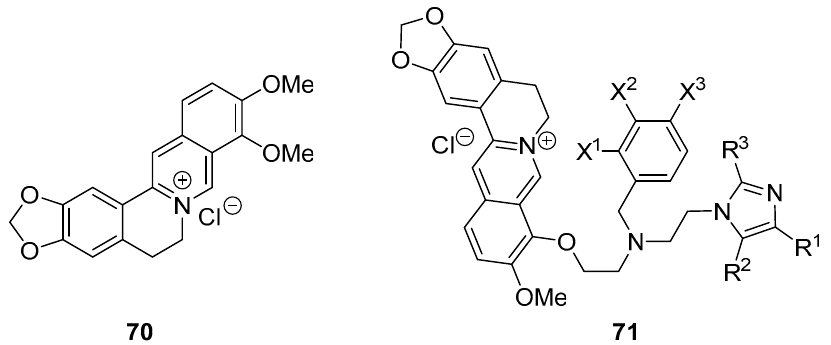
Figure 5. Structures of berberine ( 70 ) and hybrids 71.